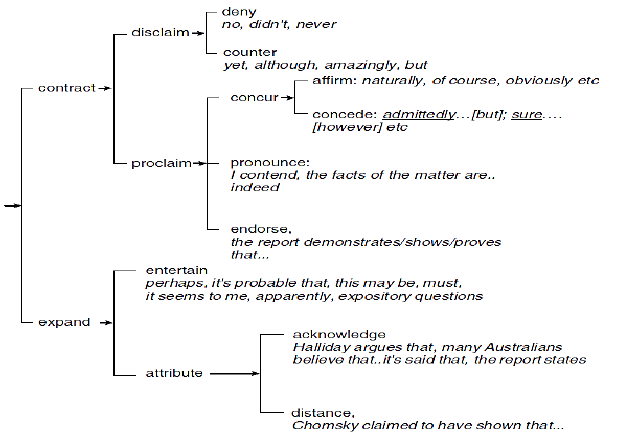
Figure 1 . Engagement System